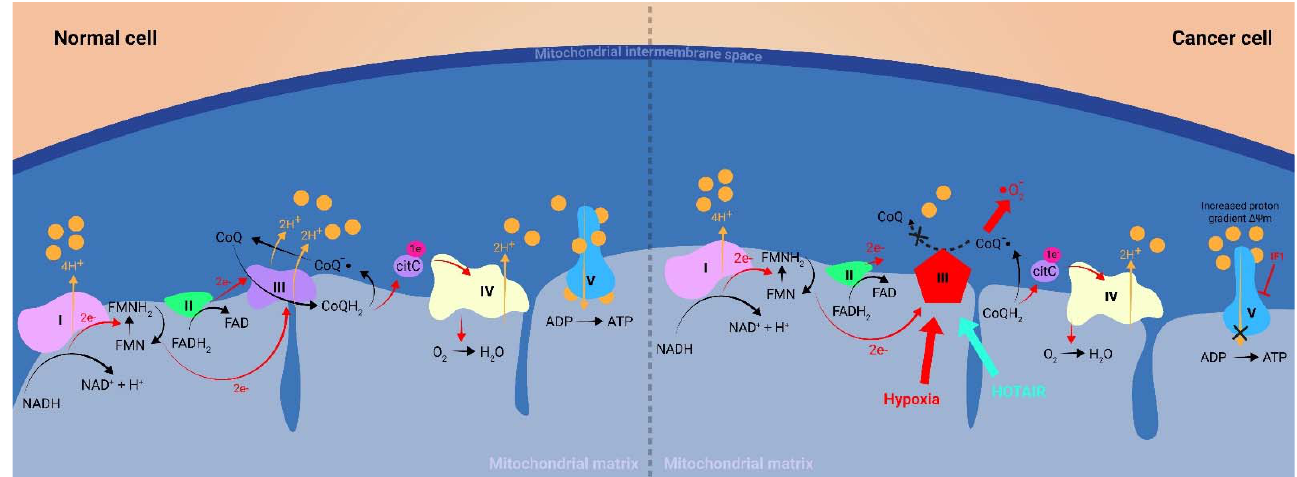
Figure 2. Mitochondrial Electron transport chain (ETC): The ETC consists of five electron exchanging protein complexes bound to the inner mitochondrial membrane. The NADH and FADH2 formed in the tricarboxylic acid chain provide the electrons to complex I and II, respectively, and the electrons are passed on from one complex to another until they reach complex IV where four electrons together with four H+ from the mitochondrial matrix react with oxygen to form two water molecules. The purpose of the ETC is that at each complex–apart from complex, II–H+ are pumped in the intermembrane space (IMS) thus creating a proton gradient between the IMS and the mitochondrial matrix, which polarizes the inner mitochondrial membrane ( ΔΨ m). This gradient is then used to power the complex V ATP-synthetase mechanism, storing energy in the phosphodiester bound formed between ADP and a molecule of H3PO4. For a more complex depiction of the ETC, see reference [93]. The hypoxic cancer cell environment alongside the increased ΔΨ m caused by oxidative phosphorylation inhibitors, such as inhibitory factor 1 (IF1), alter the ETC in such a way that the probability of ROS species formation increases as compared to a normal cell. Certain lncRNAs, such as HOTAIR, stabilize complex III and decrease the probability of ROS